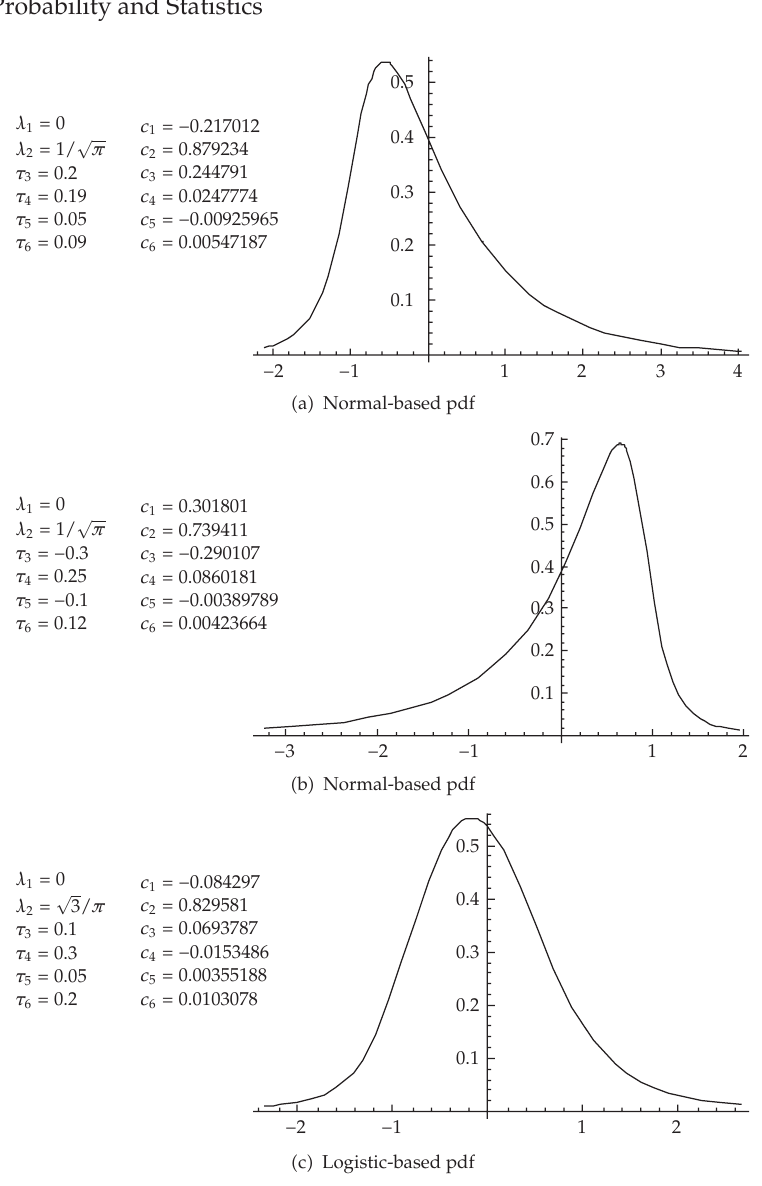
Figure 2: Standard normal and standard logistic-based power method